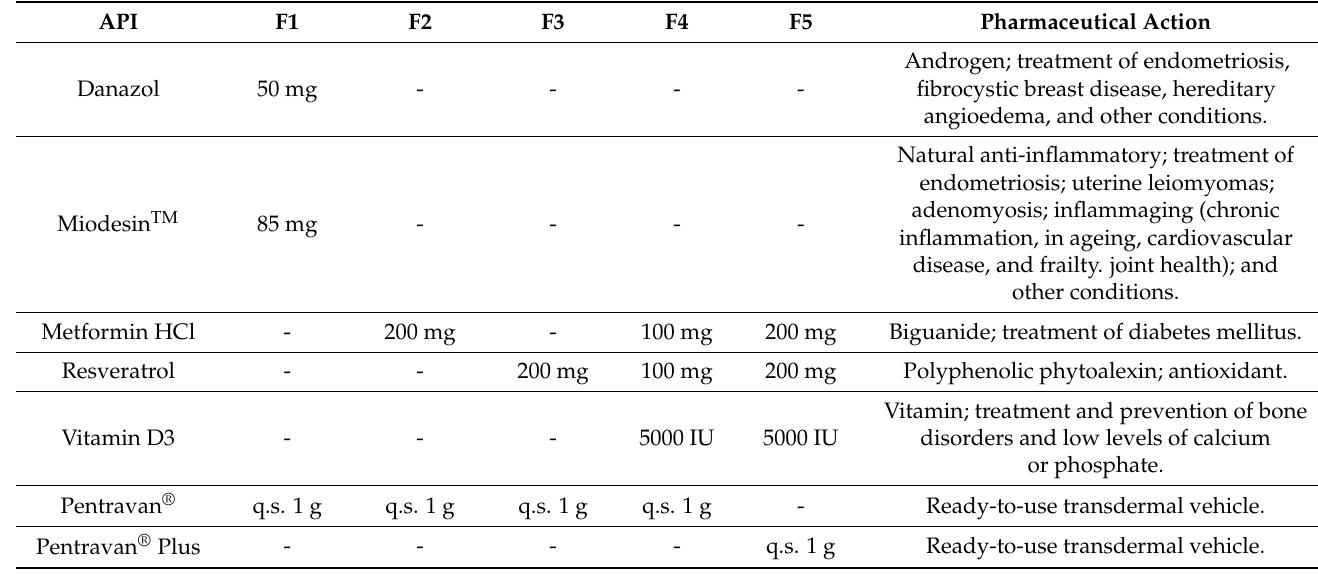
Table 1. The active pharmaceutical ingredients studied and their